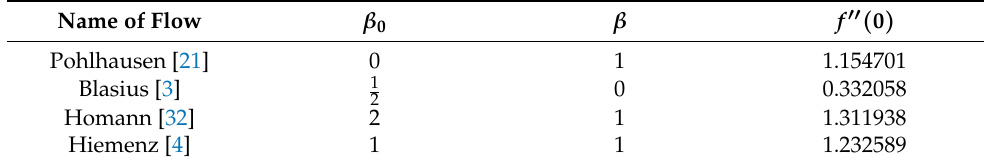
Table 1. Some standard Falkner–Skan